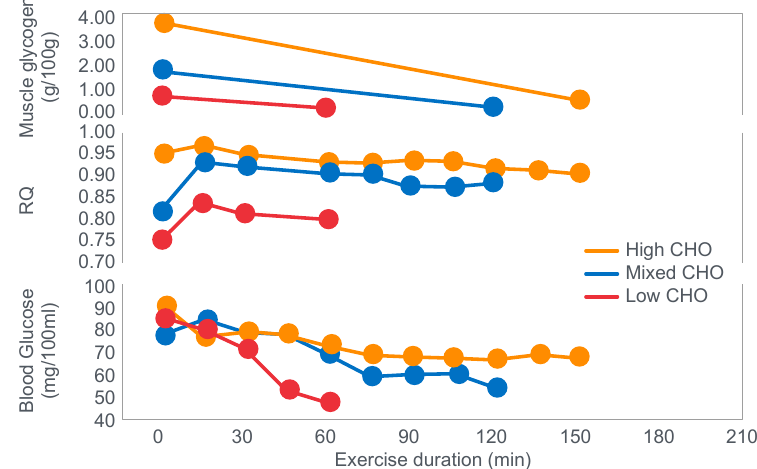
Figure 4. Changes in muscle glycogen concentrations, Respiratory Quotient (RQ) and blood glucose concentrations in subjects after acute adaptation to either high, mixed or low-carbohydrate diets. Adapted with permission from ref. [17]. Copy-right 1967 Acta Physiologica (John Wiley and Sons).